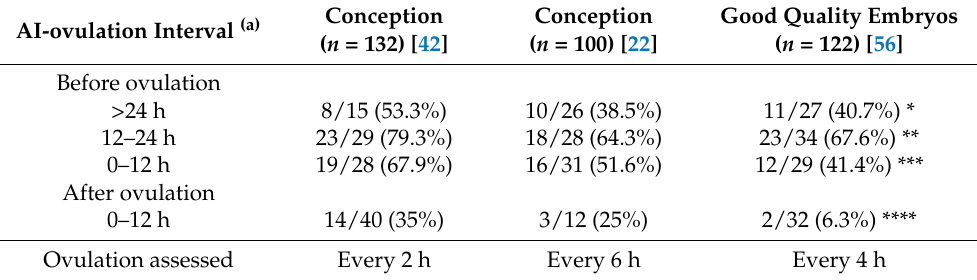
Table 1. Effects of insemination-ovulation interval on conception and rate of good quality embryos. Conception Conception Good Quality Embryos AI-ovulation Interval (a) ( n = 132) [42] ( n = 100) [22] ( n = 122) [56] Before ovulation >24 h 8/15 (53.3%) 10/26 (38.5%) 11/27 (40.7%) * 12–24 h 23/29 (79.3%) 18/28 (64.3%) 23/34 (67.6%) ** 0–12 h 19/28 (67.9%) 16/31 (51.6%) 12/29 (41.4%)